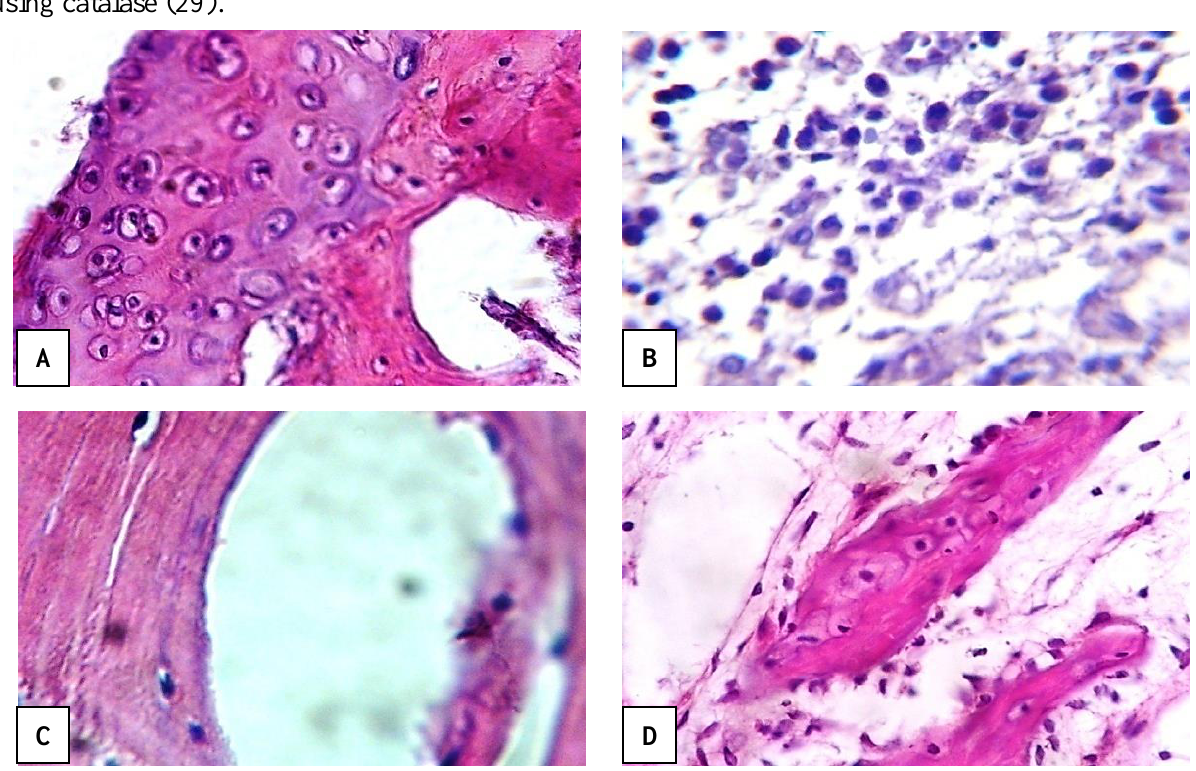
Fig, 4: Histological sections in the ankle joint of the immunized animals (30 day post inoculaiton) showed, A: few neutrophils and MNCs in the articular capsule. B: no clear lesion in the articular cartilage. C: no clear lesion in the cortical part of the subchondral bone. D: no clear inflammatory reaction in the bone trabeculae and the bone marrow with active osteoblasts lining the trabecular bone, (All sections were stained with H & E stain; A, B, C and D